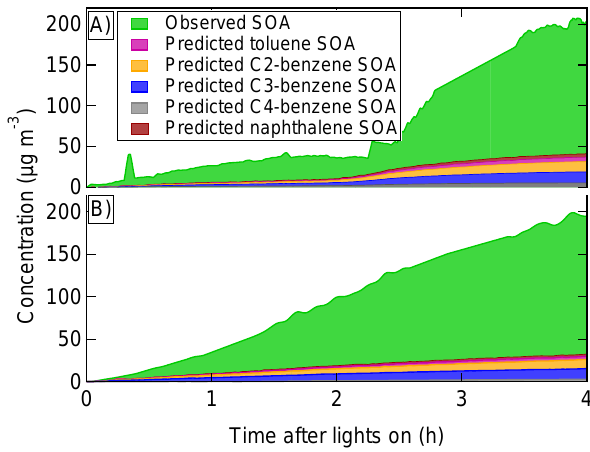
Fig. 10. Observed secondary organic aerosol (SOA) formation, wall loss corrected, green, in the mobile smog chamber during aging of emissions from a Euro 5 gasoline light-duty vehicle and predicted SOA formation based on measurement of aromatic hydrocarbon de- cay for Exp. 1 (A) and Exp. 2 (B) . Low NO x yields are used to predict SOA from the aromatics in order to provide an upper limit. Only a small fraction of observed SOA is explained by the oxidation of aromatic